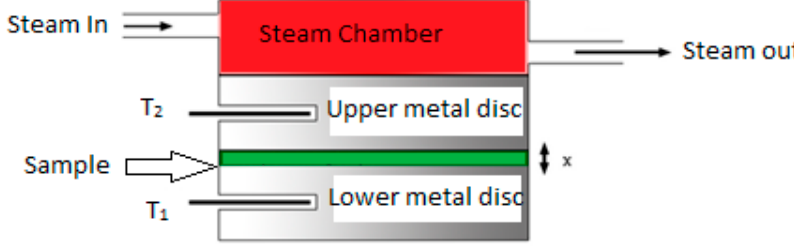
Figure 3. Lee’s disc apparatus for measurement of thermal conductivity.